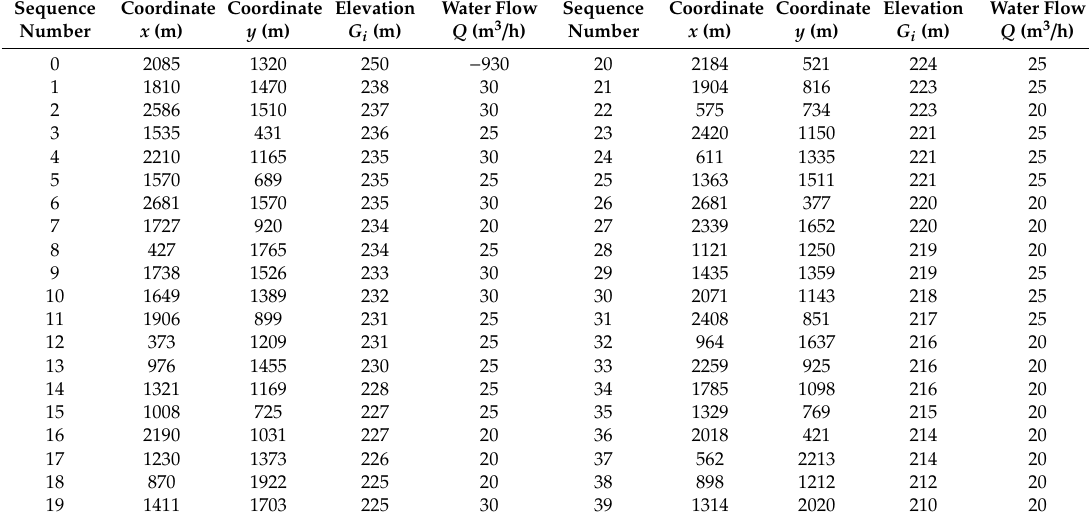
Table 7. Pipe network parameters (40